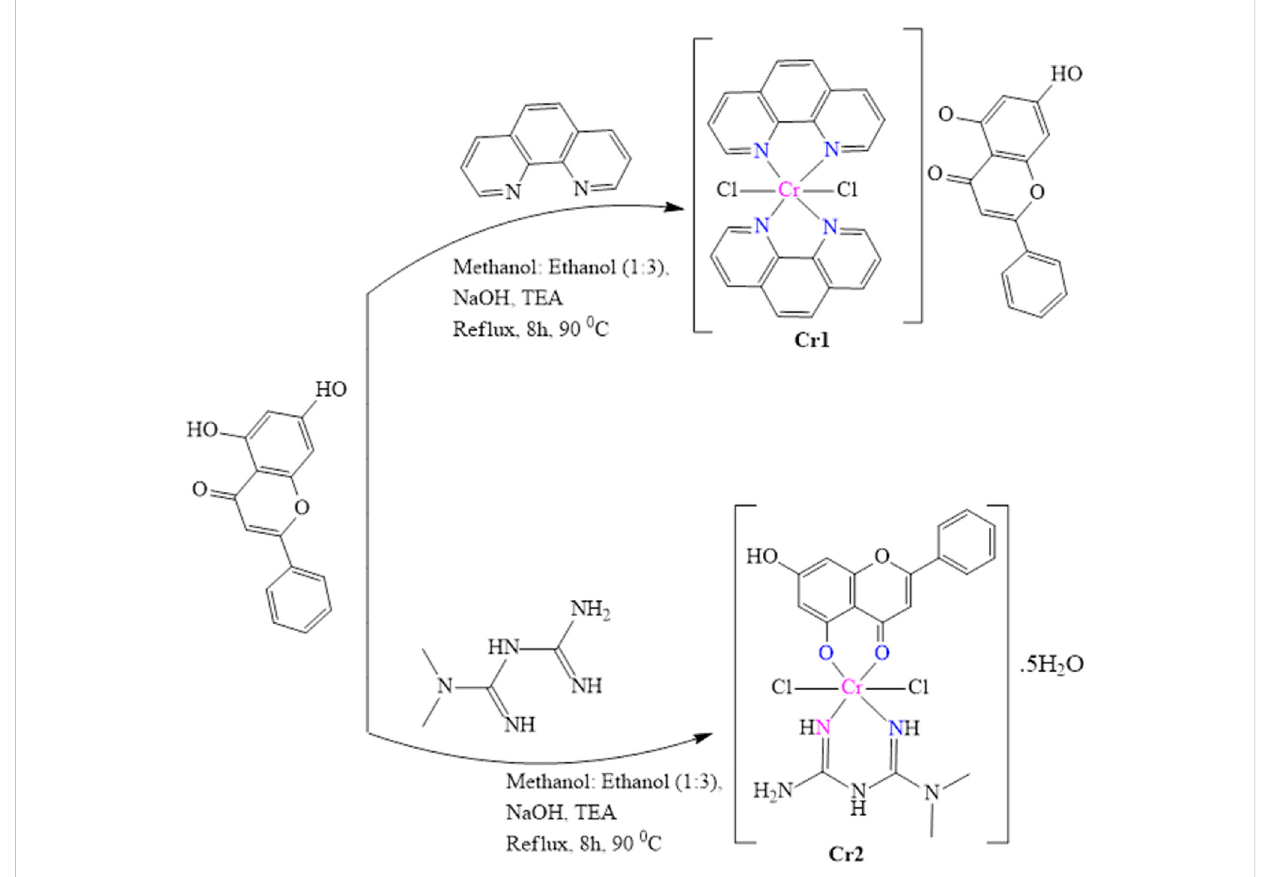
SCHEME 1 Schematic representation of the synthesis of Cr(III)